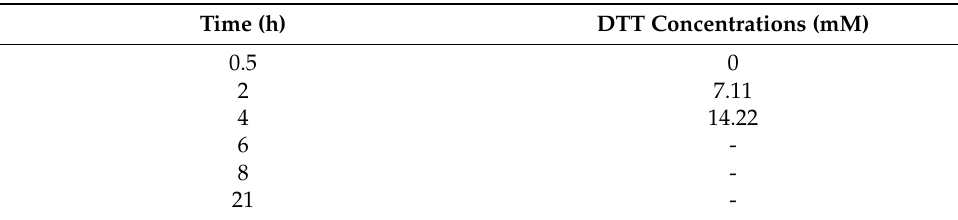
Table S1. As responses for this design of experiment (DoE), the concentration of monomeric HRP was quantified with SDS-PAGE and RPLC. Additionally, all solubilization conditions were refolded at a GSSG concentration of either 0 mM, 1.27 mM or 2.54 mM GSSG to verify the effect on the refolding yield. Table 2. Full factorial experimental design for HRP solubilization. The listed DTT concentrations were used in combination with each listed